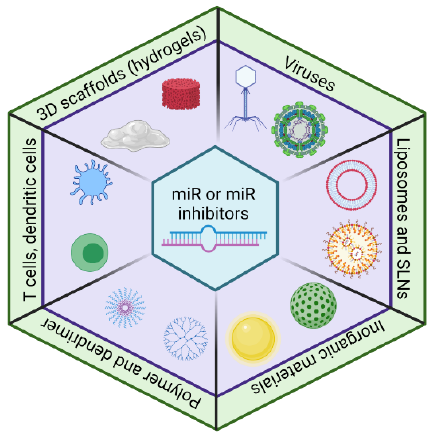
Figure 2. The delivery approaches for miRs and miR inhibitors. The viral vectors have high effi- ciency, but immunogenicity is a concern. A lipid-based delivery system (e.g., liposomes and solid lipid nanoparticles (SLNs)) is widely used for miR and miR inhibitor deliveries. Recently, inorganic material-based, polymer-based, cell-based, and 3D scaffold-based approaches have emerged as a delivery system for miRs and miR